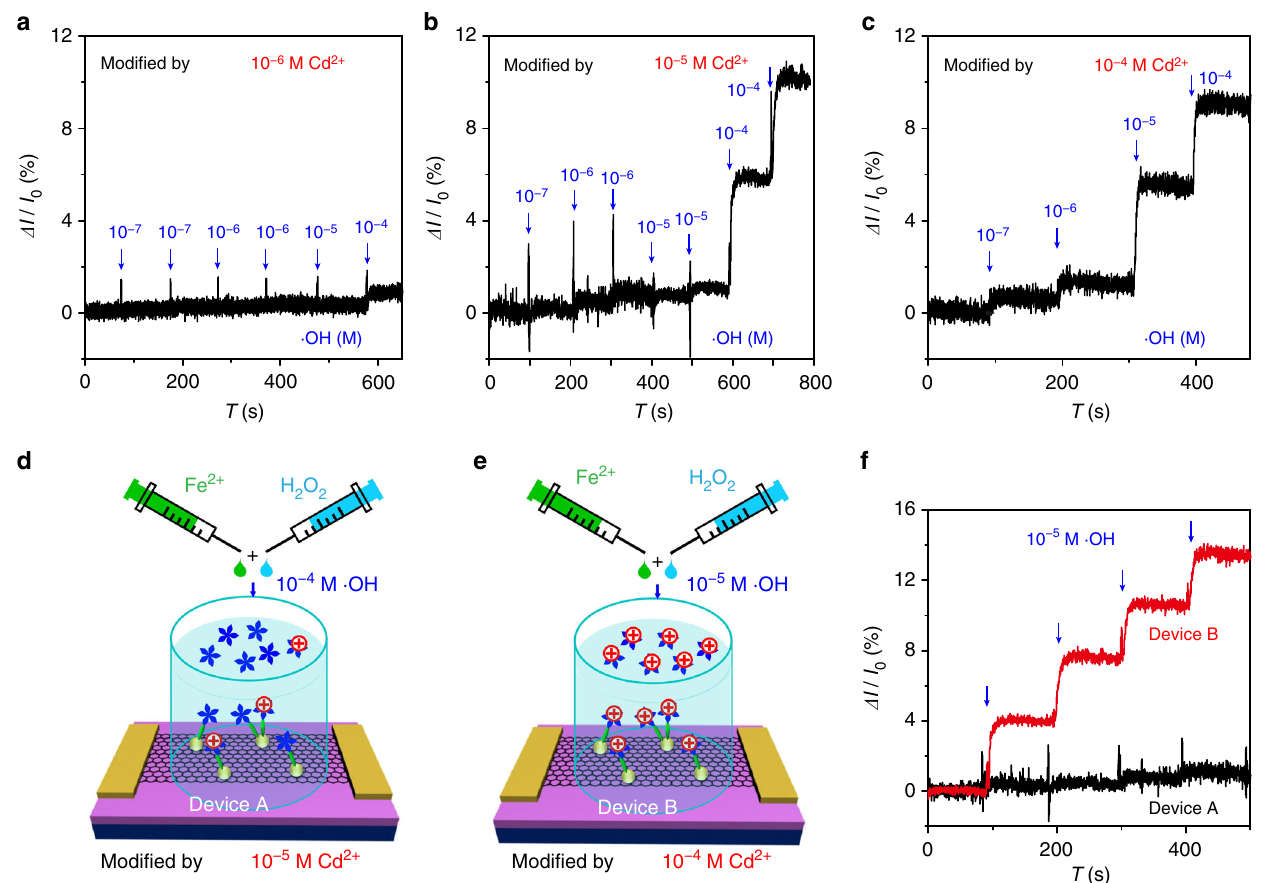
Fig. 4 Quasi-quantitative detection of (cid:129) OH. a – c Real-time response upon various concentrations of (cid:129) OH (from 10 − 7 to 10 − 4 M) for the fi eld-effect transistor (FET) sensors with channel doped with a 10 − 6 M Cd 2 + , b 10 − 5 M Cd 2 + , or c 10 − 4 M Cd 2 + . d , e Schematic diagram of the detection of (cid:129) OH using the FET sensors modi fi ed by different concentrations of Cd 2 + . f Real-time response upon successive addition of 10 − 5 M (cid:129) OH for the FET sensors with channel doped with 10 − 5 M Cd 2 + (black, Device A) and 10 − 4 M Cd 2 + (red, Device